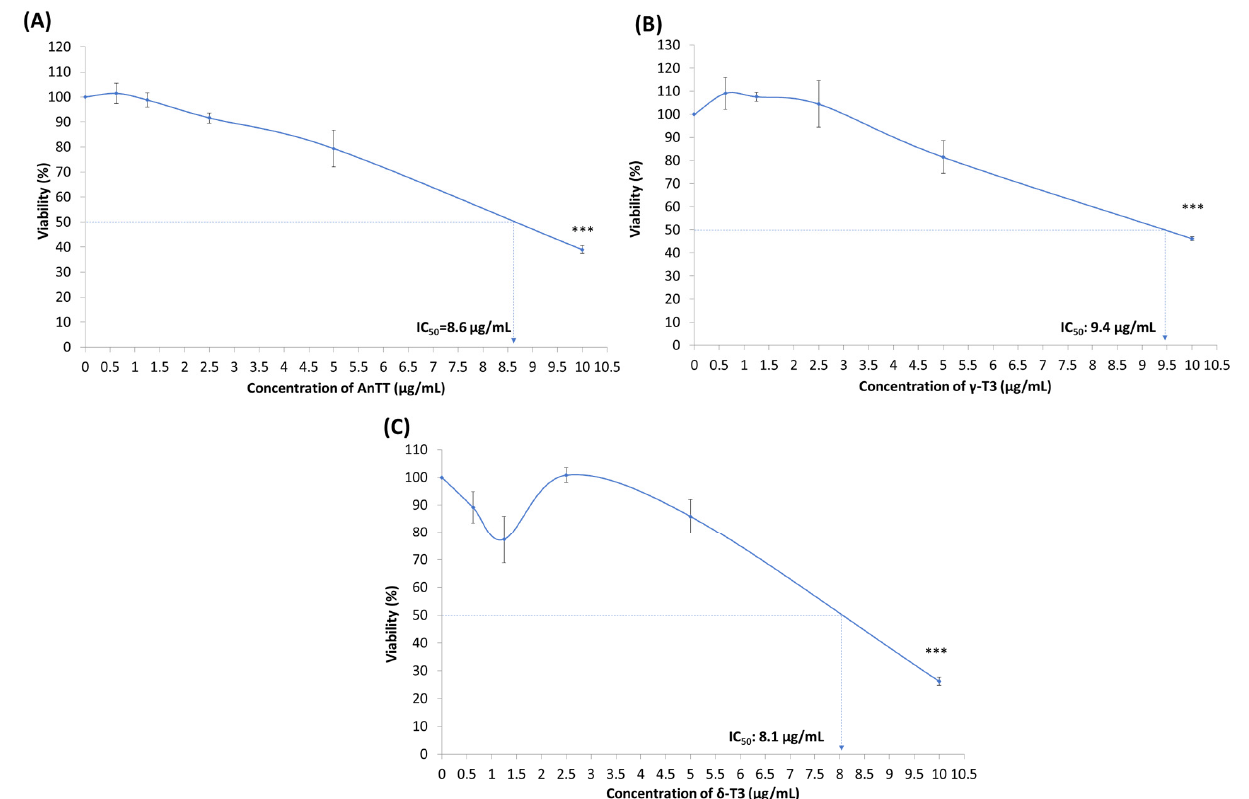
Figure 4. The antiproliferative activities of AnTT ( A ), γ -T3 ( B ) and δ -T3 ( C ) on SW1353 cells upon 72 h treatment. *** indicates a significant difference of p < 0.001 compared to VC. The viability of VC is assumed as 100%. Abbreviations: AnTT, annatto tocotrienol; δ -T3, δ -tocotrienol; γ -T3, γ -tocotrienol; IC 50 , half-maximal inhibitory concentration; VC, vehicle control.